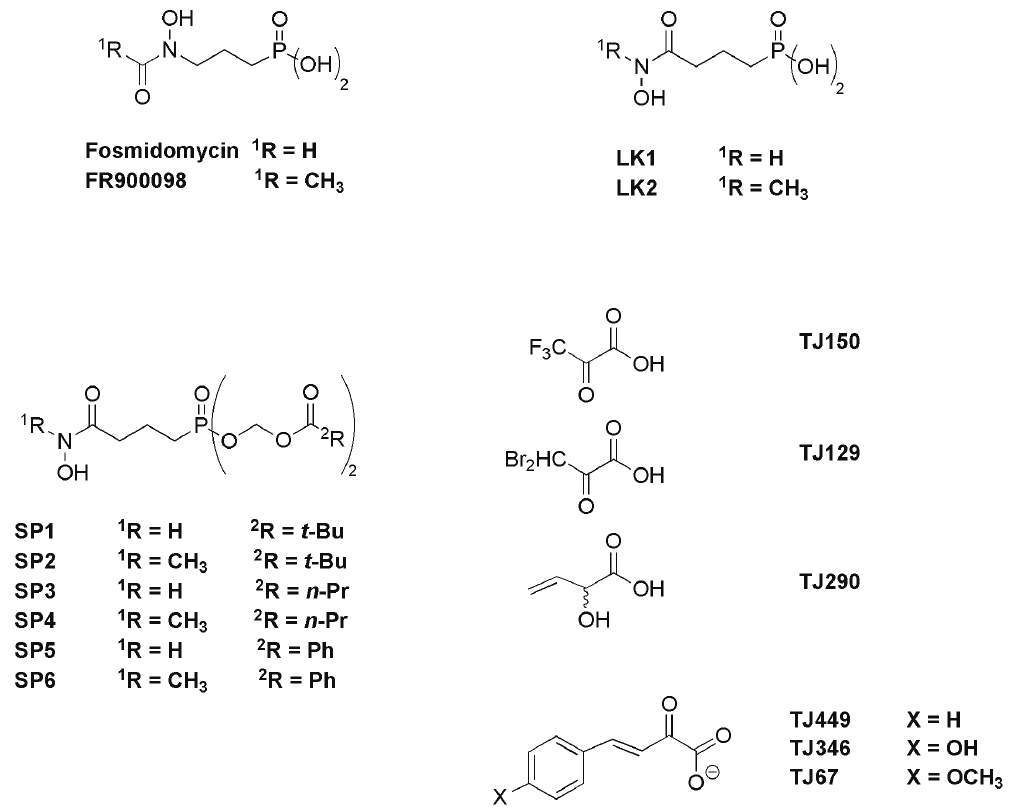
Figure S4. Structures of newly synthesized compounds and tested in this